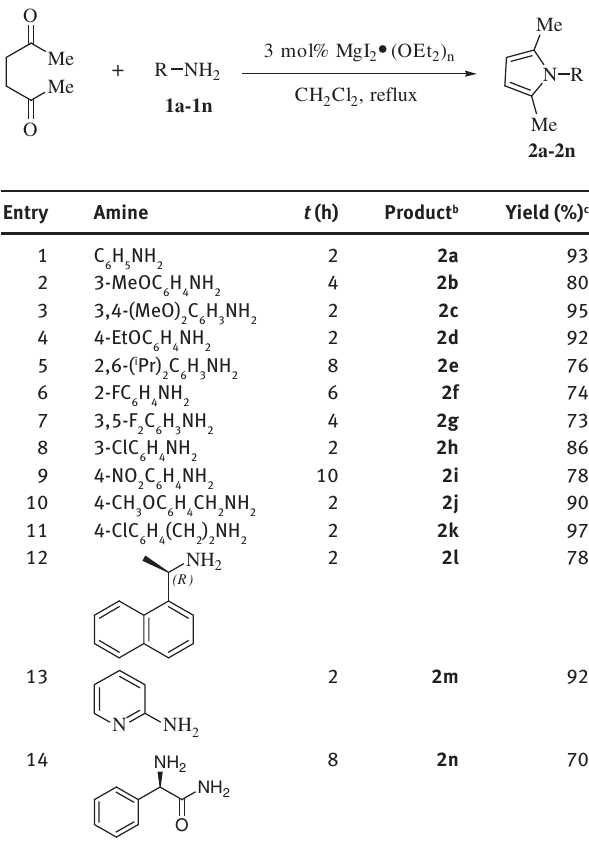
Table 1 Paal-Knorr condensation of 2,5-hexadione catalyzed by MgI etherate a 2